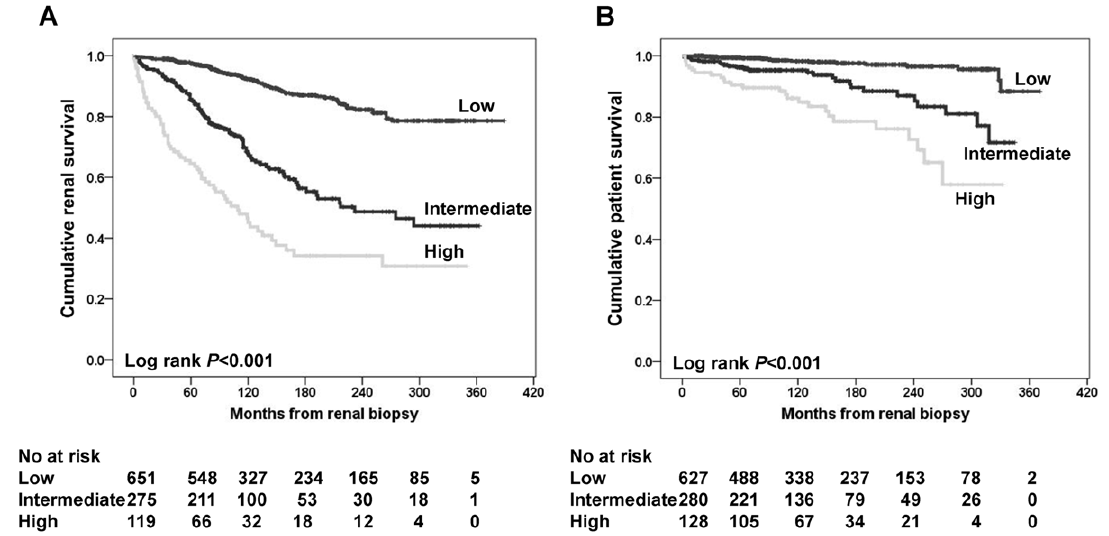
Figure 2. Cumulative renal ( A ) and patient survival ( B ) according to the risk stratification. The primary outcome is patient survival. The numbers of patients remaining at 60, 120, 180, 240, 300, and 360 months of follow-up are shown at the bottom.